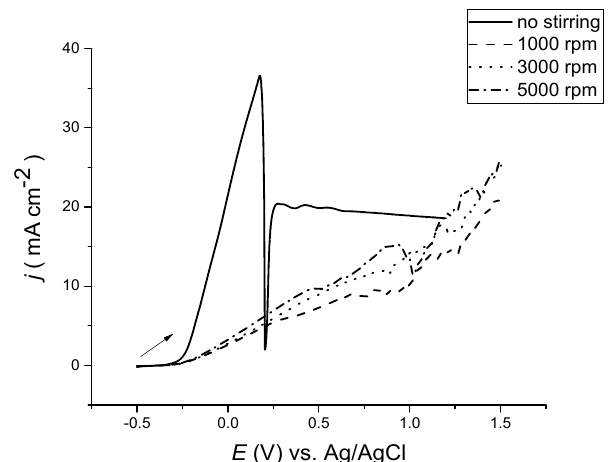
Figure 7. Anodic LSVs of Cu disc in ethaline versus Ag / AgCl, at a sweep rate of 5 mV · s − 1 and at various rotation speeds.